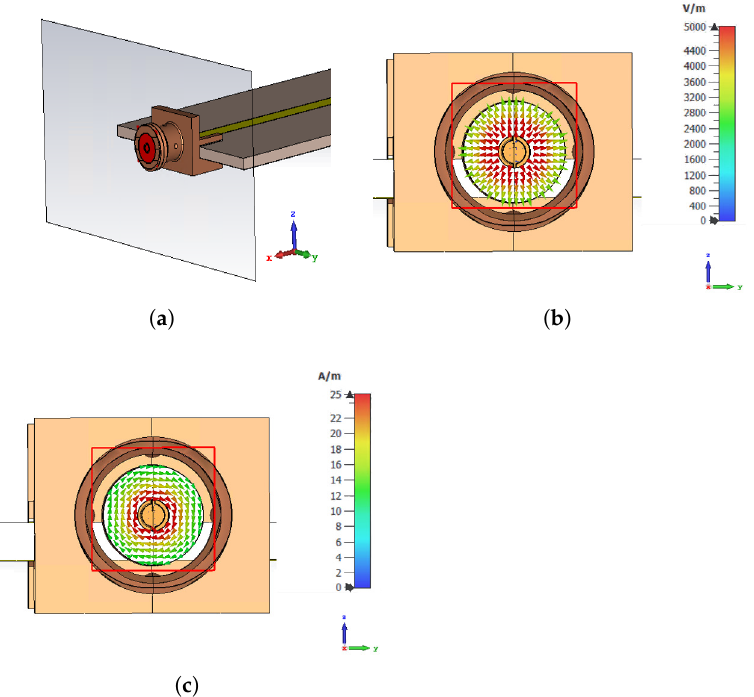
Figure 9. Coaxial excitation at the SMA connector. ( a ) Location of exciting wave guide port. ( b ) Pre- scribed (cid:126) E -field at excitation plane. ( c ) Prescribed (cid:126) H -field at excitation plane.